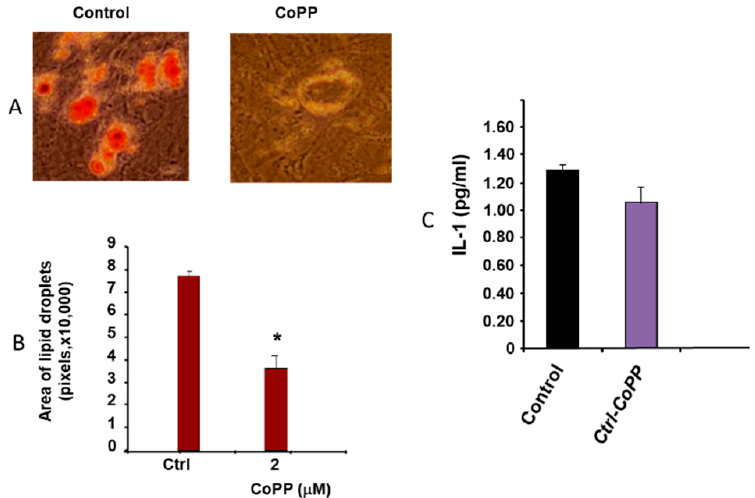
Figure 1. E ff ect of HO-1-induction by CoPP on adipogenic di ff erentiation of bone-marrow-MSC-derived adipogenesis * ( p < 0.05). This shows the e ff ect of CoPP on the adipogenic di ff erentiation of MSC derived from mice fed an HFD. ( A , B ) show the e ff ect of CoPP on the numbers of adipocytes as well as the size of the adipocytes. ( C ) shows the decrease in Figure 1. Effect of HO-1-induction by CoPP on adipogenic differentiation of